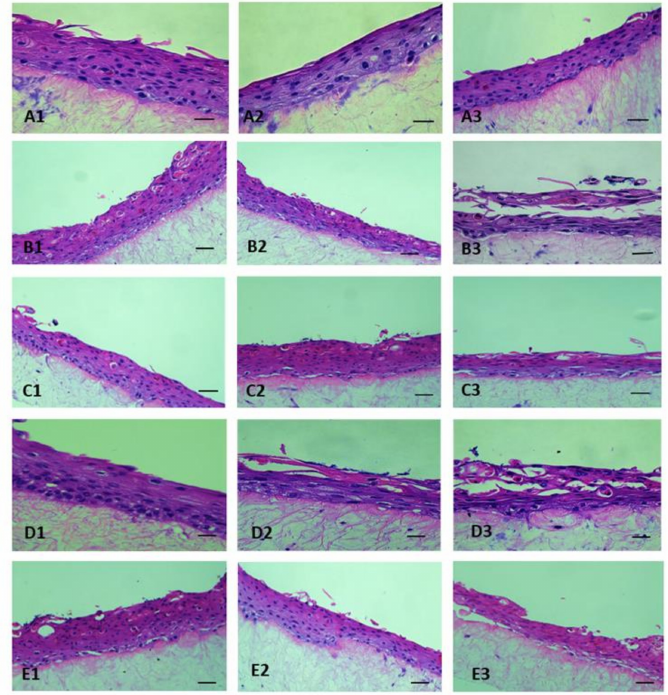
Figure 1. D-skin models at ( 1 ) 2 h, ( 2 ) 24 h, and ( 3 ) 48 h after inoculation with ( A ) PBS ( B ) ST30,